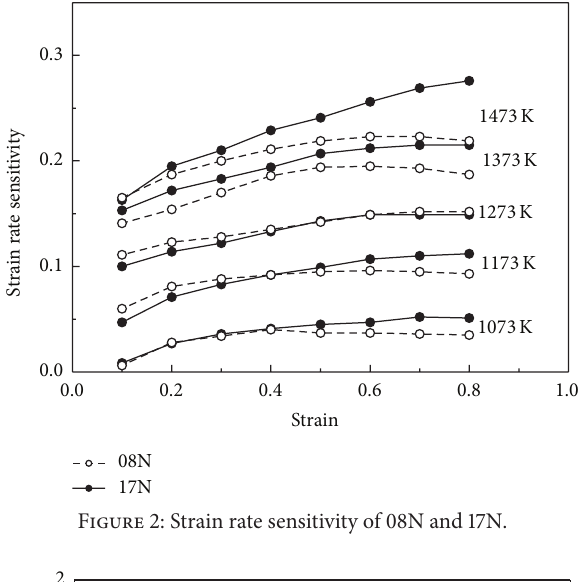
Figure 4: Relationship curves of peak stress with strain rate and deformation temperature for 316LN stainless steels: ln [ sinh (𝛼𝜎)] and 1/𝑇 × 10 4 .